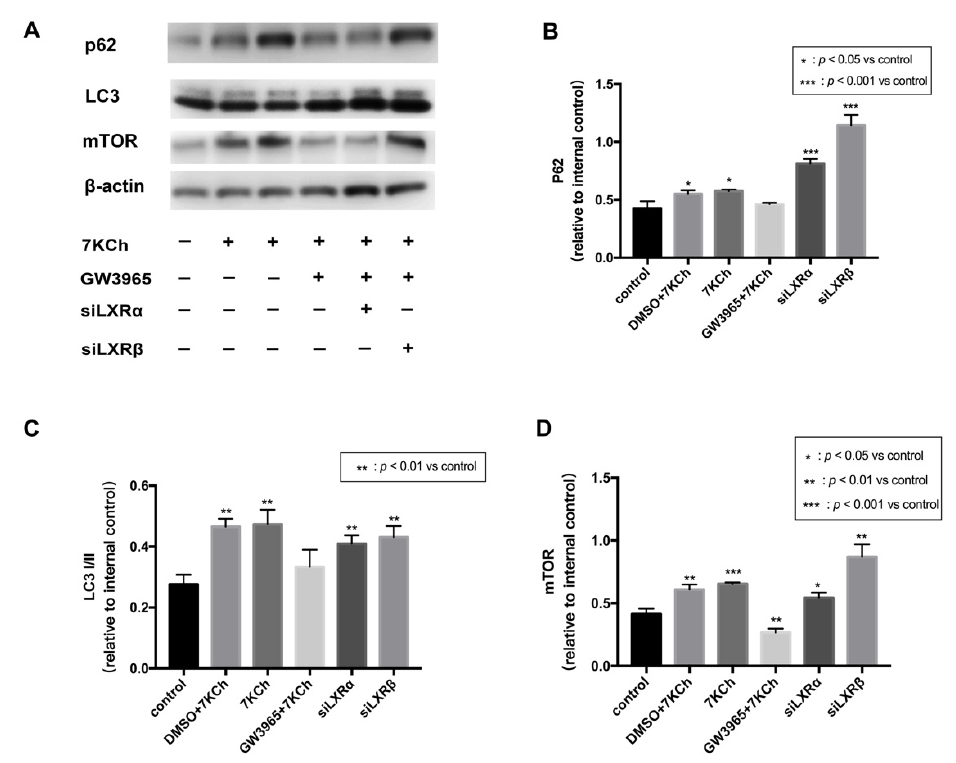
Figure 9. Western blot of proteins in ARPE-19 cells. ( A ) As a control, ARPE-19 cells were cultured with a serum-free medium for 48 h. (DMSO) ARPE-19 cells were incubated with DMSO (0.02%) for 24 h, followed by 7KCh (20 µ M) for 24 h. (7KCh) ARPE-19 cells were cultured with serum-free medium for 24 h and then incubated with 7KCh (20 µ M) for 24 h. (GW3965) ARPE-19 cells were incubated with GW3965 (2 µ M) for 24 h, followed by 7KCh (20 µ M) for 24 h. (siLXR α ) ARPE-19 cells were first transfected with siLXR α as previously described and then incubated with 7KCh (20 µ M) and GW3965 (2 µ M) for 24 h. (siLXR β ) ARPE-19 cells were first transfected with siLXR β as previously described and then incubated with 7KCh (20 µ M) and GW3965 (2 µ M) for 24 h. Total protein was collected from the cultured ARPE-19 cells. ( B ) P62 expression levels in ARPE-19 cells. ( C ) LC3I/II expression levels in ARPE-19 cells. ( D ) mTOR expression levels in ARPE-19 cells. Data are represented as mean ± SEM of three independent experiments. Differences with p < 0.05 were considered statistically